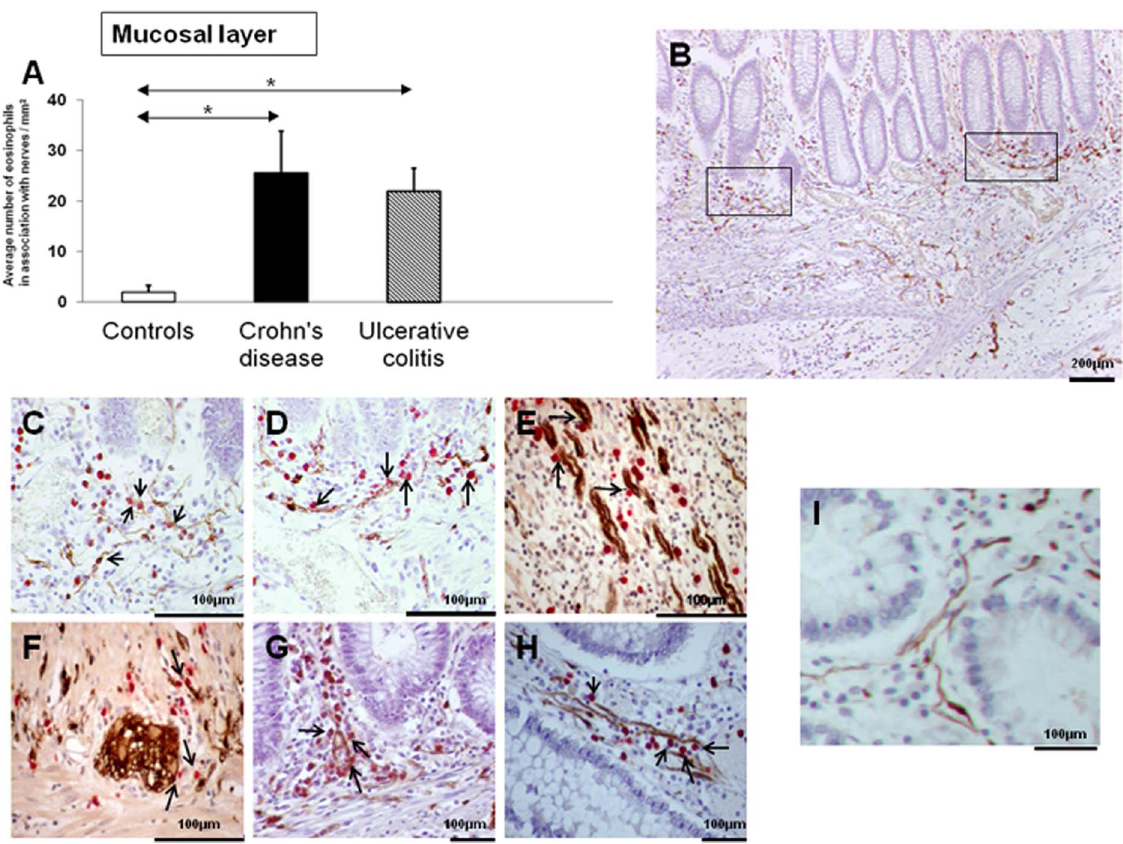
Figure 2. Quantification of eosinophil localization to mucosal nerves in patients with refractory IBD. Eosinophils localize to nerves in the colonic mucosa of patients with refractory IBD. The number of MBP immmunoreactive eosinophils in association with nerves/mm 2 is shown for controls and subjects with refractory (unresponsive) CD and UC (A). Control patients n=8; CD n=8; UC n=7.The data are expressed as mean 6 SEM, *p , 0.05. The photomicrograph shown in (B) represents a section taken from a patient with refractory CD. The boxed areas from (B) are shown in higher magnification in (C) and (D). Eosinophils, stained red were detected with anti-MBP antibody, while nerves, stained brown were detected with anti-S100 antibody. There is significant accumulation of eosinophils in these sections compared to the control section shown in photomicrograph (I). Photomicrographs (E) and (F) demonstrate neuroeosinophilic co-localization in a refractory CD section in more detail. Photomicrographs (G) and (H) represent sections from a patient with refractory ulcerative colitis. The arrows in (C-H) demonstrate MBP stained eosinophils in contact or in close association with S100 stained nerves. In all sections note the absence of detectable extra-cellular MBP deposition.